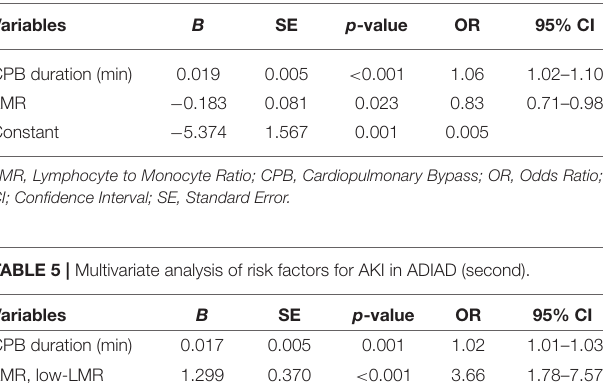
TABLE 3 | Univariate analysis of risk factors for AKI in ADIAD. TABLE 4 | Multivariate analysis of risk factors for AKI in ADIAD (first).